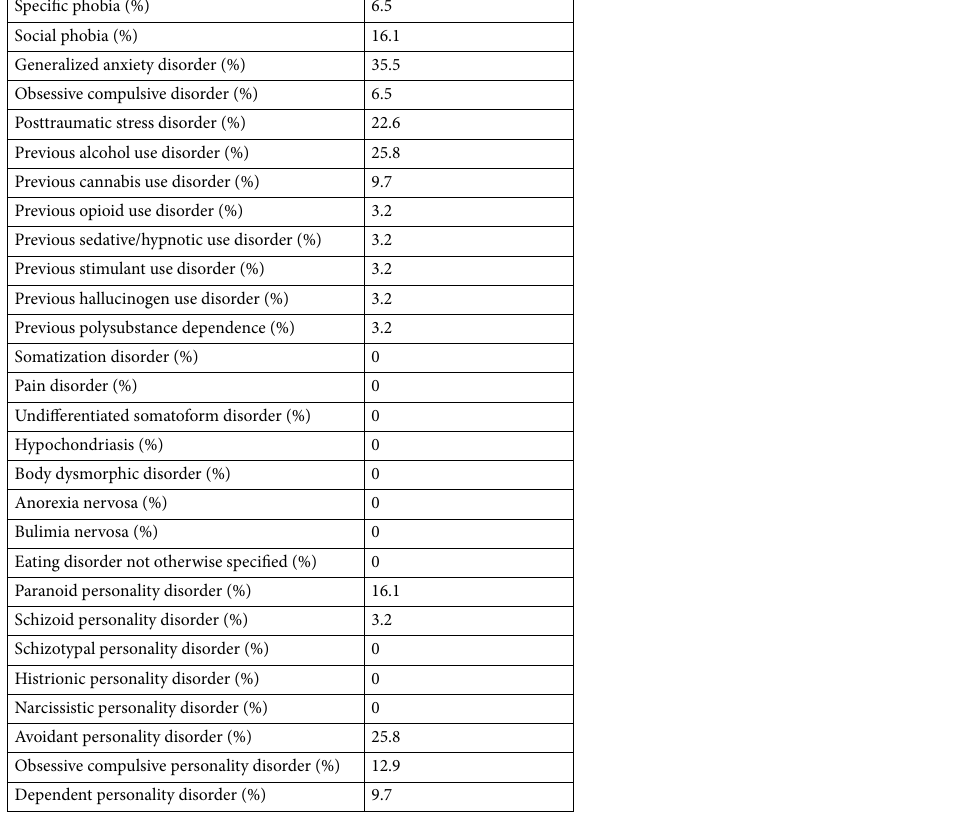
Table 2. Comorbid psychiatric